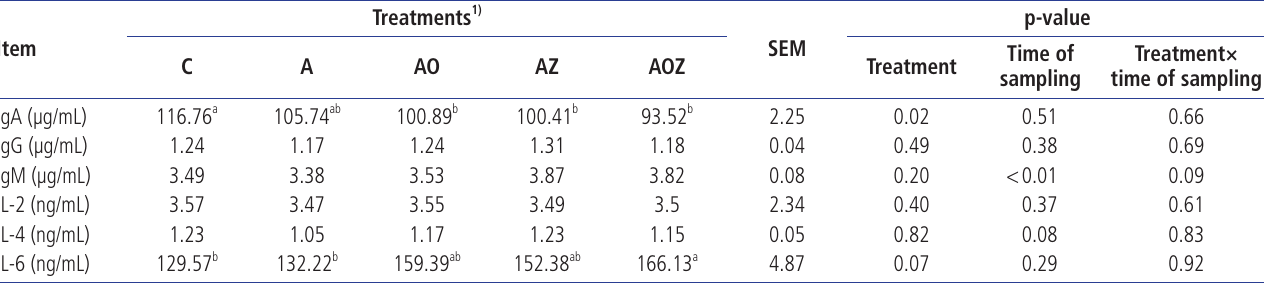
Table 5. Effects of AFB1, OTA, and ZEA on serum immunoglobulin and cytokines concentrations in dairy goats Item